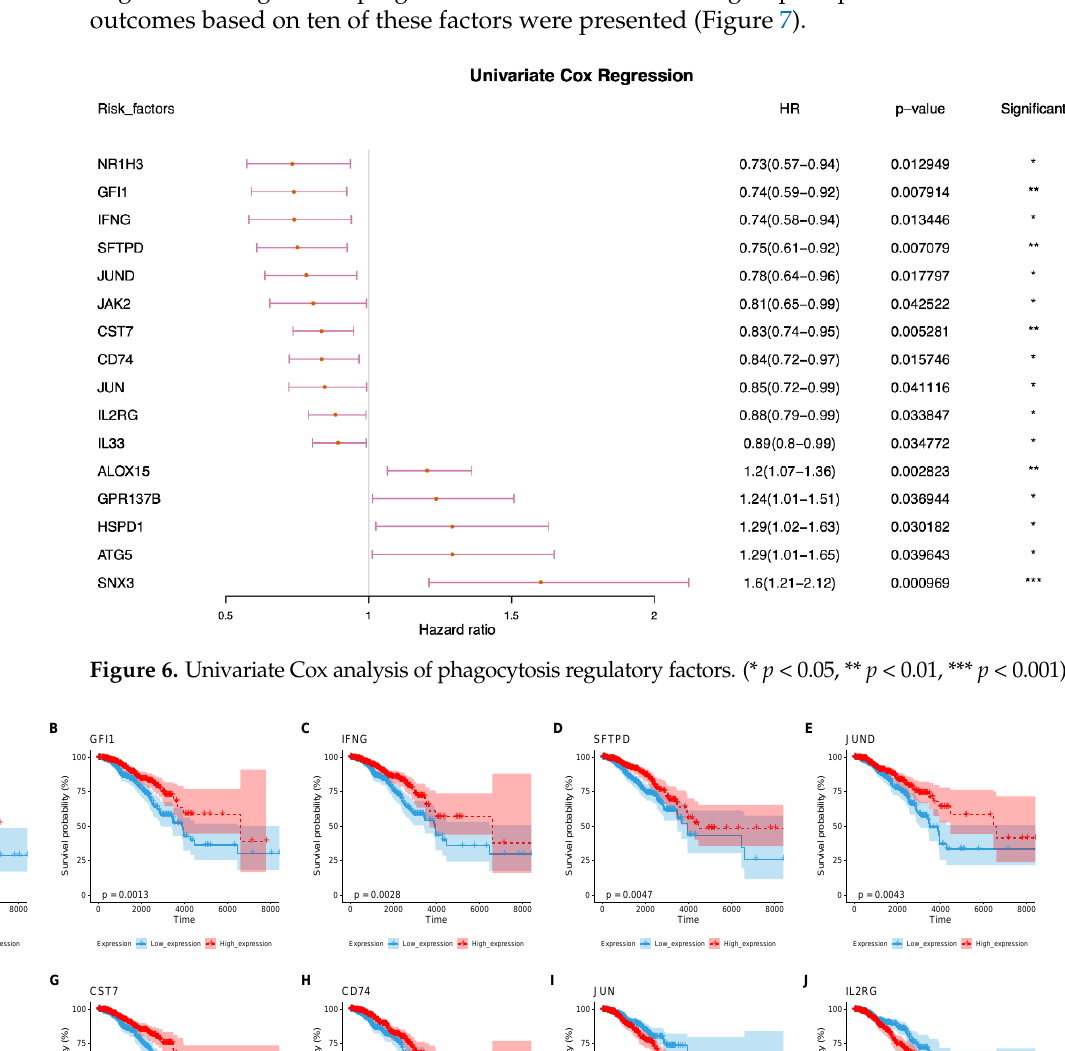
Figure 5. Sample clustering based on phagocytic factors. ( A – C ) Clustering results and parameters of